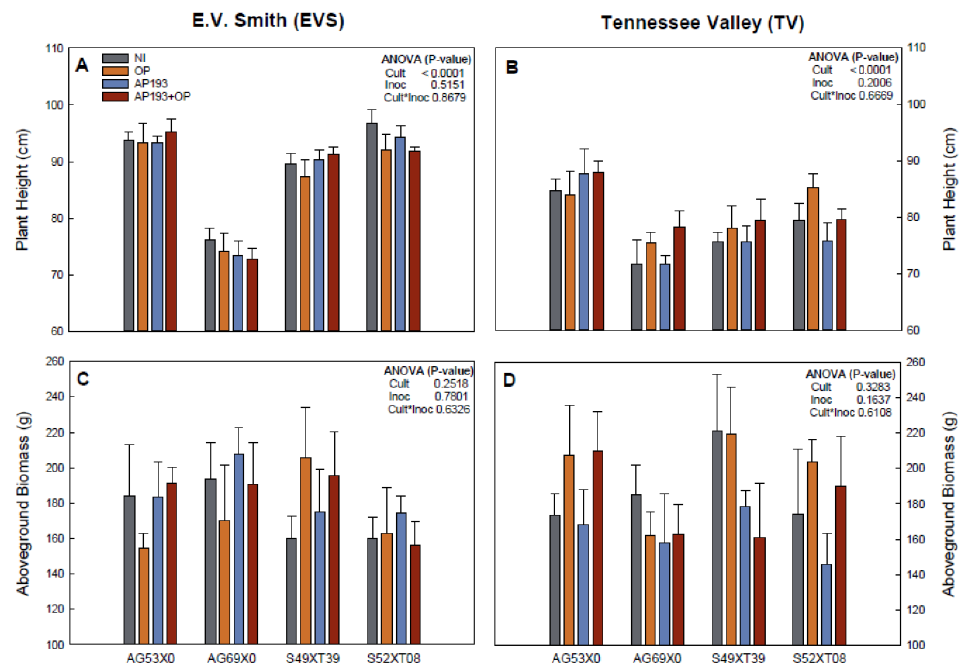
Figure 2. Plant height ( A , B ) and total aboveground dry biomass ( C , D ) for four different soybean cultivars grown at field conditions during Summer 2020 at two locations in Alabama, USA (E.V. Smith and Tennessee Valley). Four inoculation treatments were tested at sowing time: Non-inoculated control (NI), orange peel alone (OP), Bacillus velezensis strain AP193 alone (AP193),and the combination of Bacillus velezensis strain AP193 and orange peel (AP193+OP). Bars represent the standard error for each treatment.